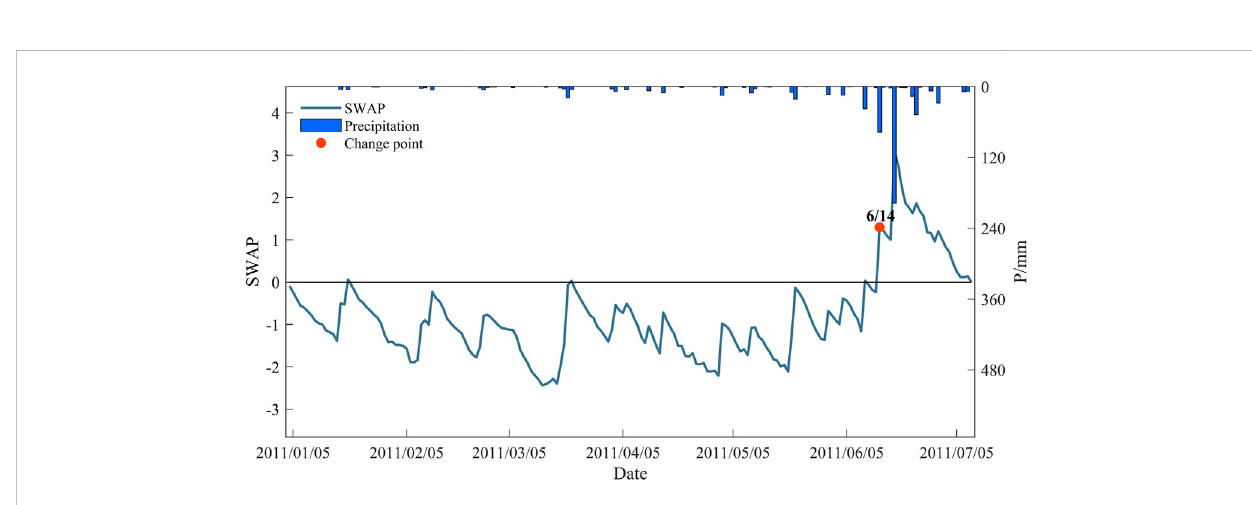
FIGURE 8 Relationship between SWAP and precipitation during the DTF event in 2011 at the Wuhan